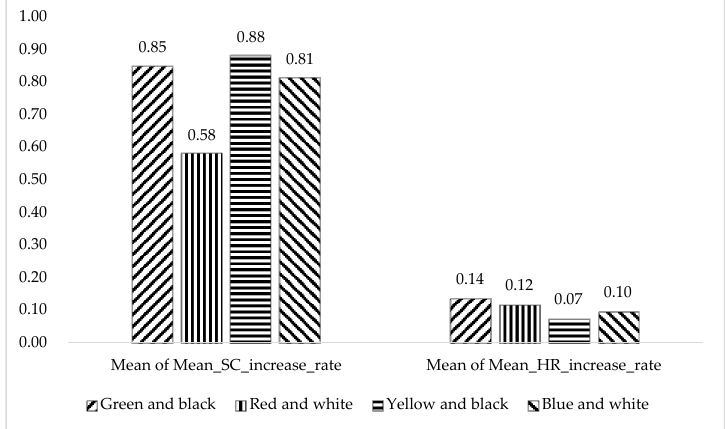
Figure 10. Mean of Mean_SC_increase_rate and mean of Mean_HR_increase_rate in the four color groups.